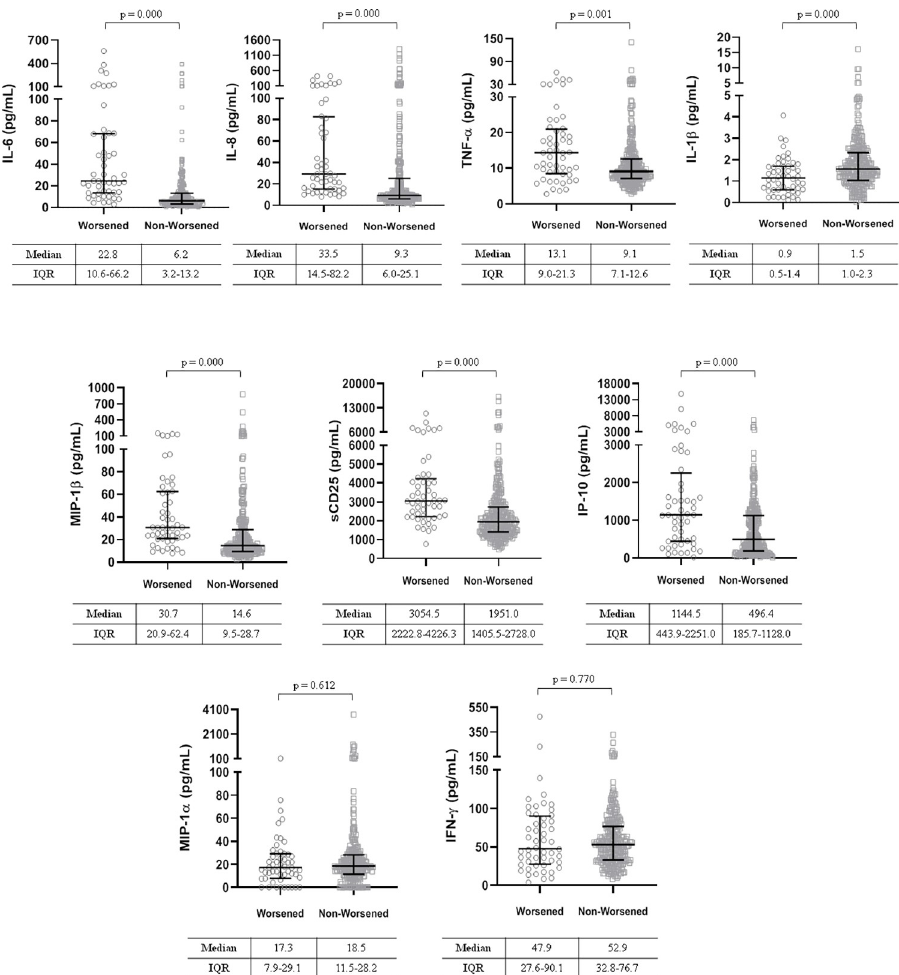
Fig 4. Differences in baseline plasma cytokine concentrations in mild patients according to whether they worsened during the first week of hospitalization or not. IL-6, interleukine-6; IL-8, interleukine-8; TNF- α , tumor necrosis factor α ; IL-1 β , interleukine-1 β ; MIP-1 β , macrophage inflammatory proteins 1 β ; sCD25, soluble receptor interleukine-2; IP-10, interferon γ -induced protein 10; MIP-1 α , macrophage inflammatory proteins 1 α ; IFN- γ ,